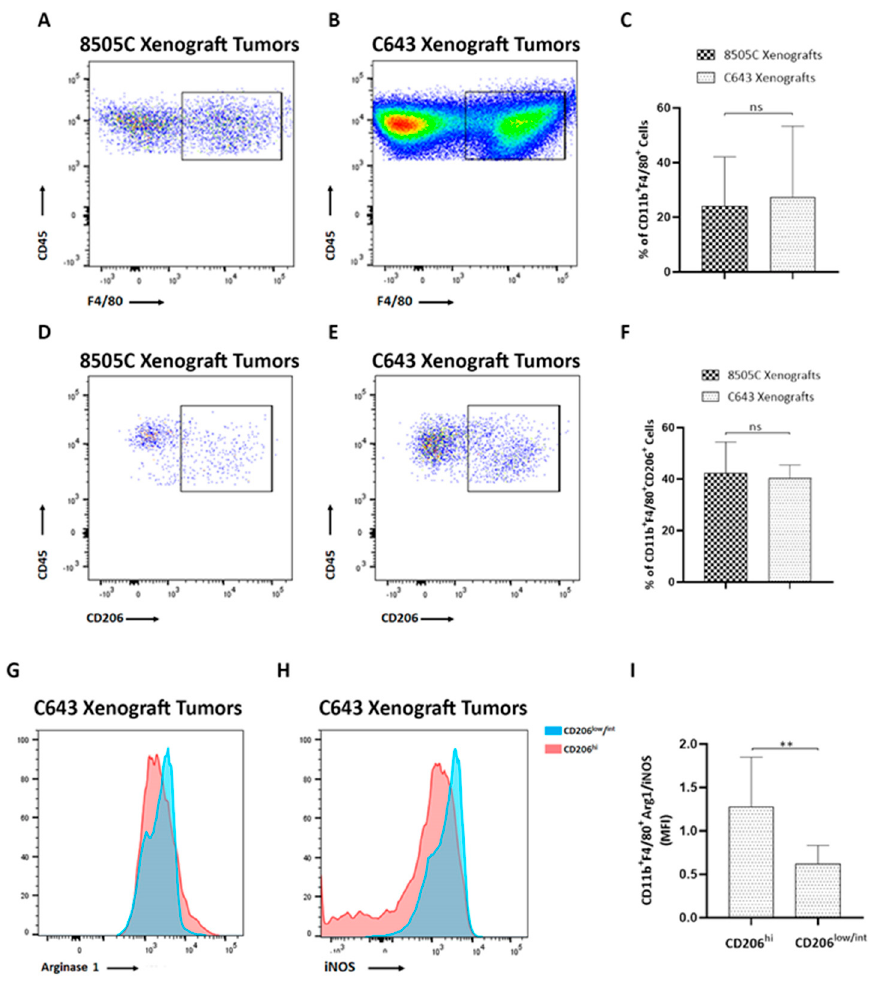
Figure 3. M2-like macrophages were recruited to ATC xenograft tumors. ( A , B ) Representative FACS analysis of macrophages (CD11b + F4/80 + ) out of all CD45 + cells infiltrating 8505C xenograft tumors ( A ) and C643 xenograft tumors ( B ). ( C ) Quantification of the percentage of CD11b + F4/80 + cells ( n = 8–10). ( D , F ) Representative FACS analysis of M2-macrophages (CD11b + F4/80 + CD206 + ) out of all CD45 + cells infiltrating 8505C xenograft tumors ( D ) and C643 xenograft tumors ( E ). ( F ) Quantification of the percentage of CD11b + F4/80 + CD206 + cells ( n = 3-5). ( G , H ) Representative histograms of Arg1 ( G ) and iNOS ( H ) expression in CD206 low/int (blue histograms) and CD206 high (pink histograms) populations in total cells from C643 xenograft tumors. ( I ) Mean fluorescence intensity (MFI) of Arg1/iNOS ratio in the CD206 high group and in the CD206 low/int group ( n = 8-10). Data are expressed as mean ± SEM of 3 independent experiments. ** p < 0.005.